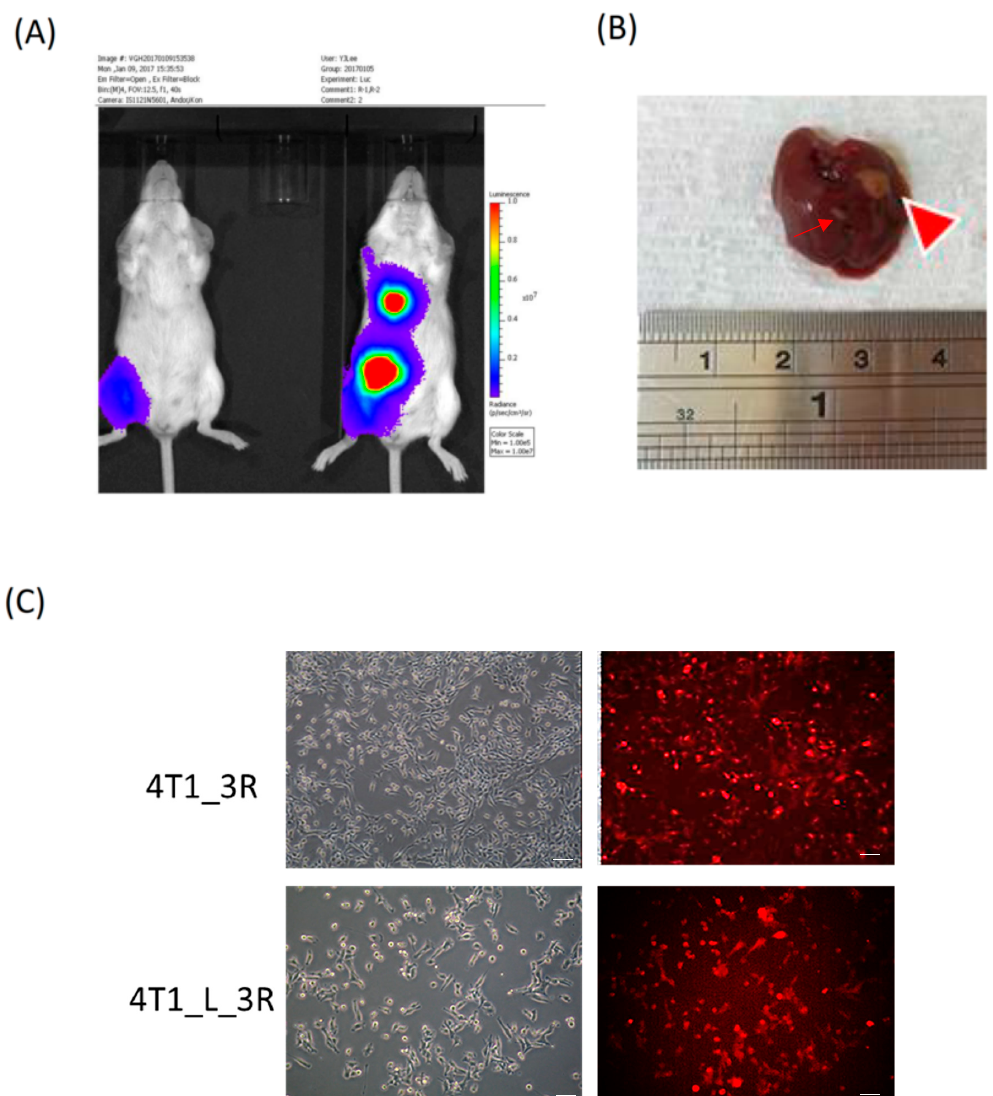
Figure 1. Tracking and isolation of liver-metastatic 4T1_3R breast cancer cells in Balb/C mice. ( A ) Coronal views of bioluminescent signals acquired at different time points after initial subcutaneous (s.c.) injection of 4T1_3R cells. ( B ) Resection of liver for the visualization of metastatic lesions. A major lesion (big arrowhead) and a minor lesion (thin arrow) were observed in the resected liver. ( C ) Fluorescence microscopic examination of red fluorescent protein (RFP) expression in isolated liver-metastatic 4T1_3R cells (4T1_L_3R) compared to original 4T1_3R cells. Scale bars = 100 μ m.